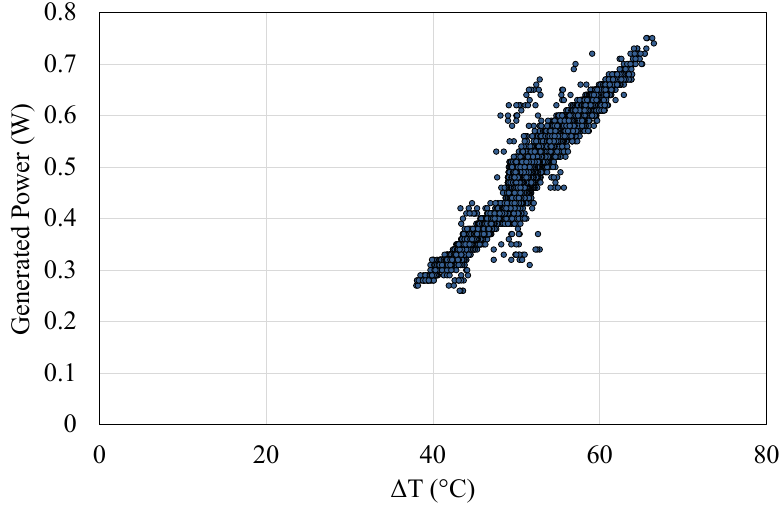
Figure 15. Power generated by M2 versus the temperature difference between their sides ∆ T = T H − T C between 19 December 2019 and 20